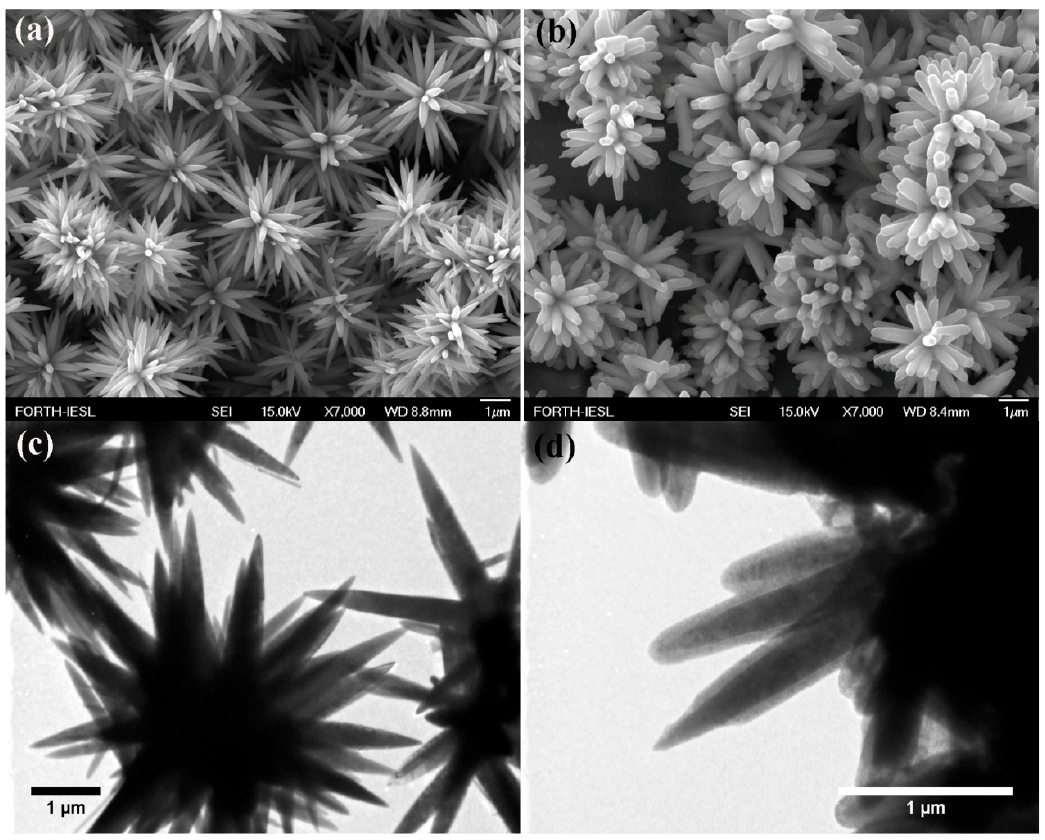
Figure 2. ( a , b ) SEM and ( c , d ) TEM images of the ZnO flower-like structures ( a , c ) and the ZnO–TiO 2 core-shell heterostruc- tures ( b , d ).